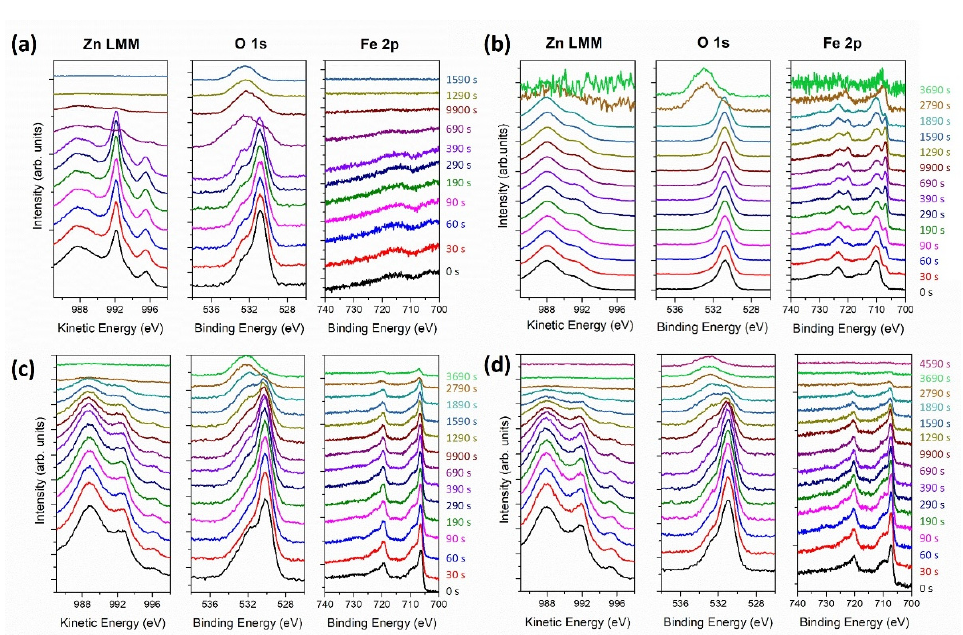
Figure 5. XPS spectra of the coating as a function of sputtering time: ( a ) pure Zn; ( b ) Zn-Fe alloy; ( c ) Zn NLs + Fe NPs; and ( d ) Zn-Fe NLs.